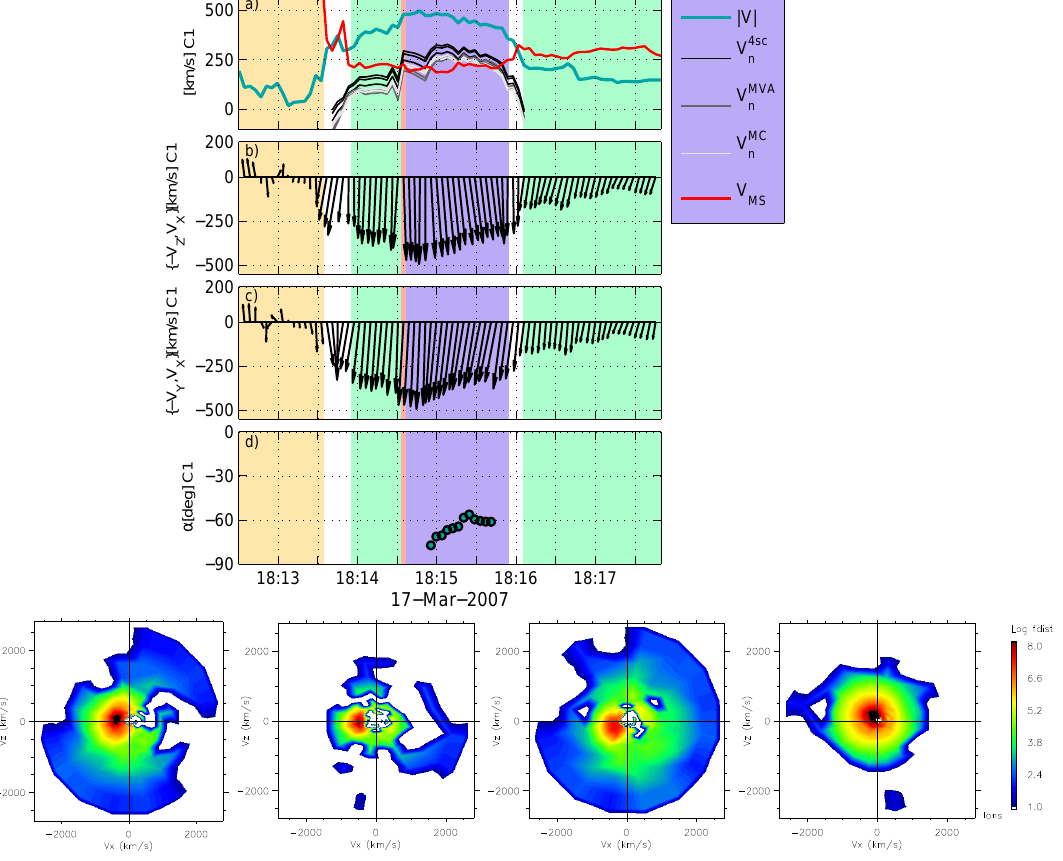
Fig. 5. C1/CIS-HIA velocity observations near a supermagnetosonic magnetosheath jet. The colour coding for different plasma regions is the same as in Fig. 4. (a) The total plasma speed V is depicted by the light blue curve and the magnetosonic speed V MS = by the red curve. The group of curves in black, grey, and white depict the component of plasma velocity parallel to the shock normal V n in the frame of reference moving with the shock. The three black lines show the results of the four-spacecraft timing method, the two grey lines of Minimum Variance Analysis (MVA) and Mass Flux Algorithm, and the two white lines of magnetic co-planarity (MC) and Mass Flux Algorithm. (b, c) Bulk velocity projection to ( − Z GSE , X GSE ) and ( − Y GSE , X GSE ) planes. Deflection of the arrows to the left thus means flow deflection to the positive Z GSE or Y GSE direction. (d) The angle α (see the inset of Fig. 1c) calculated from the observed velocity deflection using the Rankine-Hugoniot jump conditions for high M A and compression ratio r = 4. The calculation is not expected to be valid at the edges of the jet where the shock is weak, and hence α is shown for the center only. Bottom: HIA ion distributions in the (V X ,V Z ) plane (cut through V Y = 0) at 18:14:06, 18:14:43, 18:15:33, and 18:16:27UT. The scale is in distribution function units, i.e., phase space density of ions (cid:1) s 3 km (cid:0) 6 . Panels (b) and (d) are from Hietala et al. (2009).